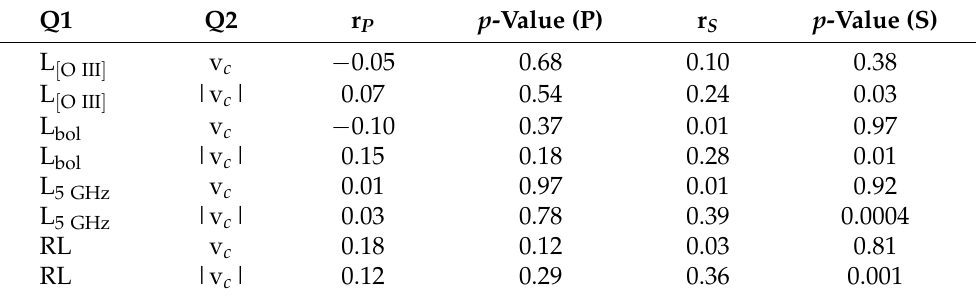
Table 3. Results of the correlations between the [O III] core shift and the physical properties of the sources. Columns: (1) First tested sample; (2) second tested sample; (3) Pearson correlation